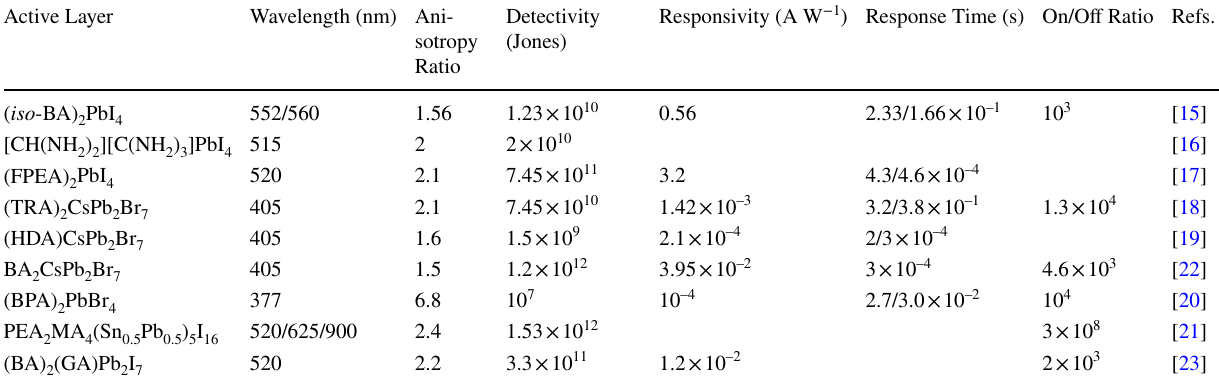
Table 2 Performance for low-dimensional LP-PPDs Active Layer Wavelength (nm) Ani-